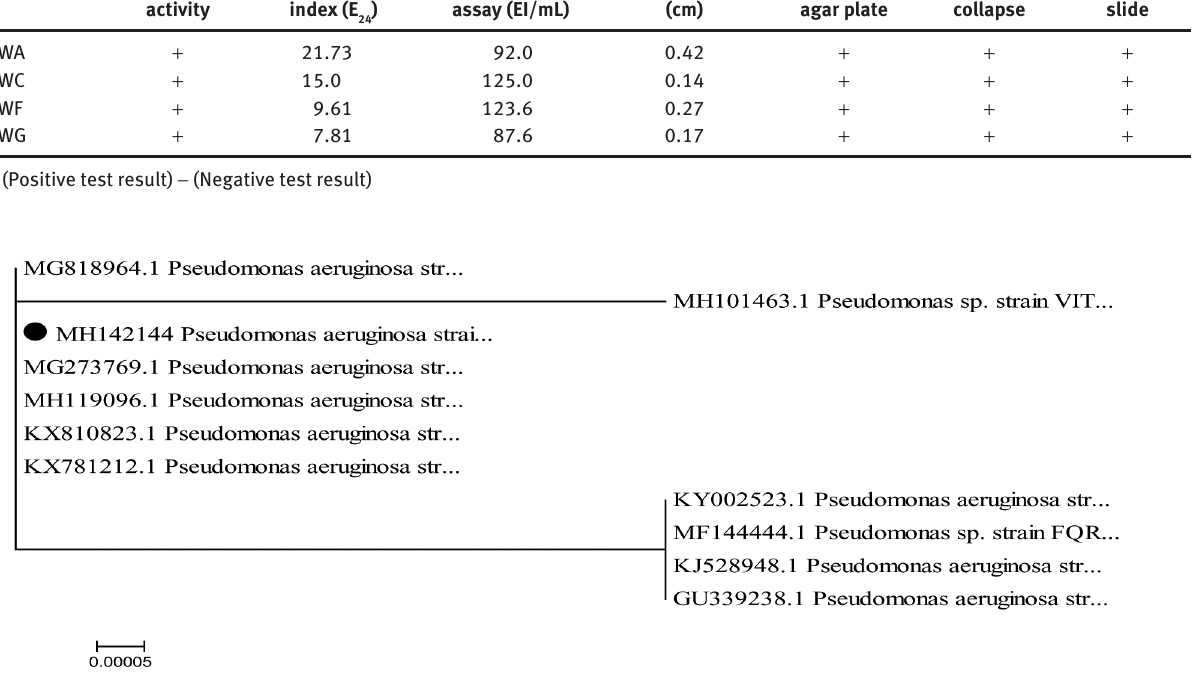
Figure 1: The phylogenetic tree of Pseudomonas aeruginosa ; MH142144 (strain PWC) and related strains based on 16S rRNA sequences, was constructed by the neighbor-joining method using MEGA4. Strain PWC (MH142144) is indicated by circle